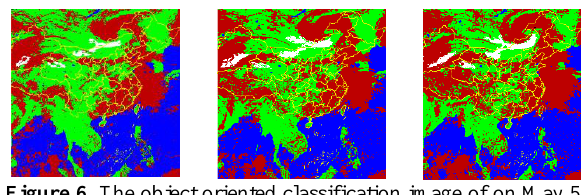
Figure 6 . The object oriented classification image of on May 5, 2016. From left to right, they are 3:00, 5:00, 7:00UTC. Table 3 . The Overall Accuracy and Kappa Coefficient of the object-oriented classification results at 3:00, 5:00, 7:00 UTC on